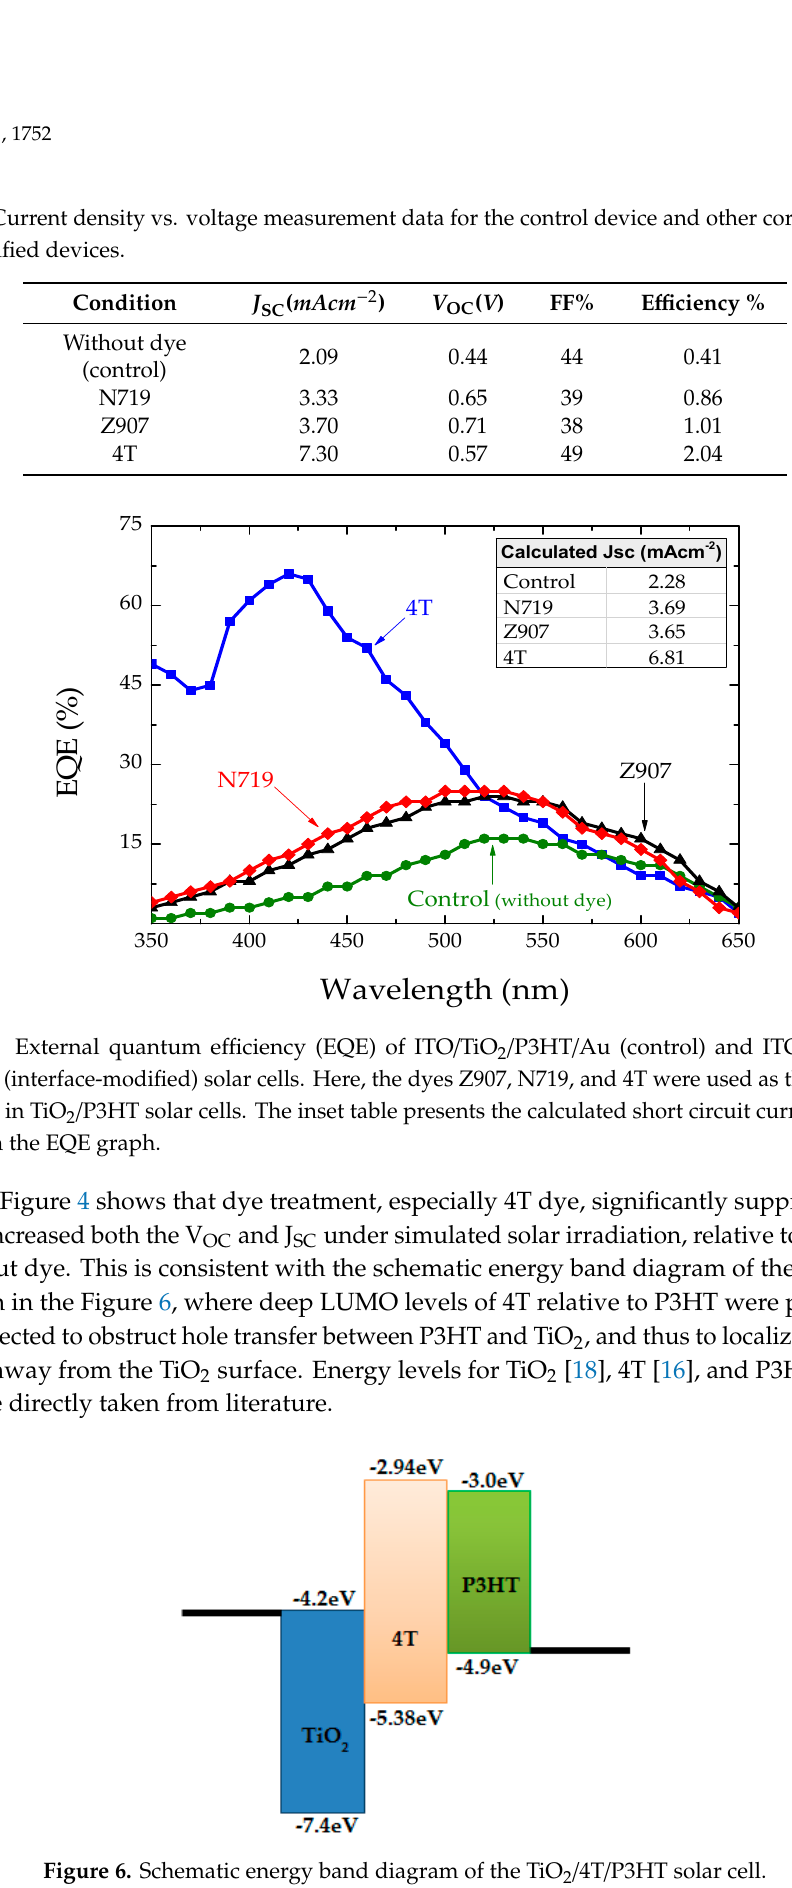
Figure 7. Distribution of power conversion efficiencies of six cells fabricated with three different 194 concentrations (box indicates the standard deviations, whiskers indicate the range, and the small 195 square in the middle of each box indicates the average). 196 Table 2. Photon conversion efficiencies (PCEs) of recently reported TiO 2 /P3HT solar cells with various 197 interface modifiers including dyes. 198